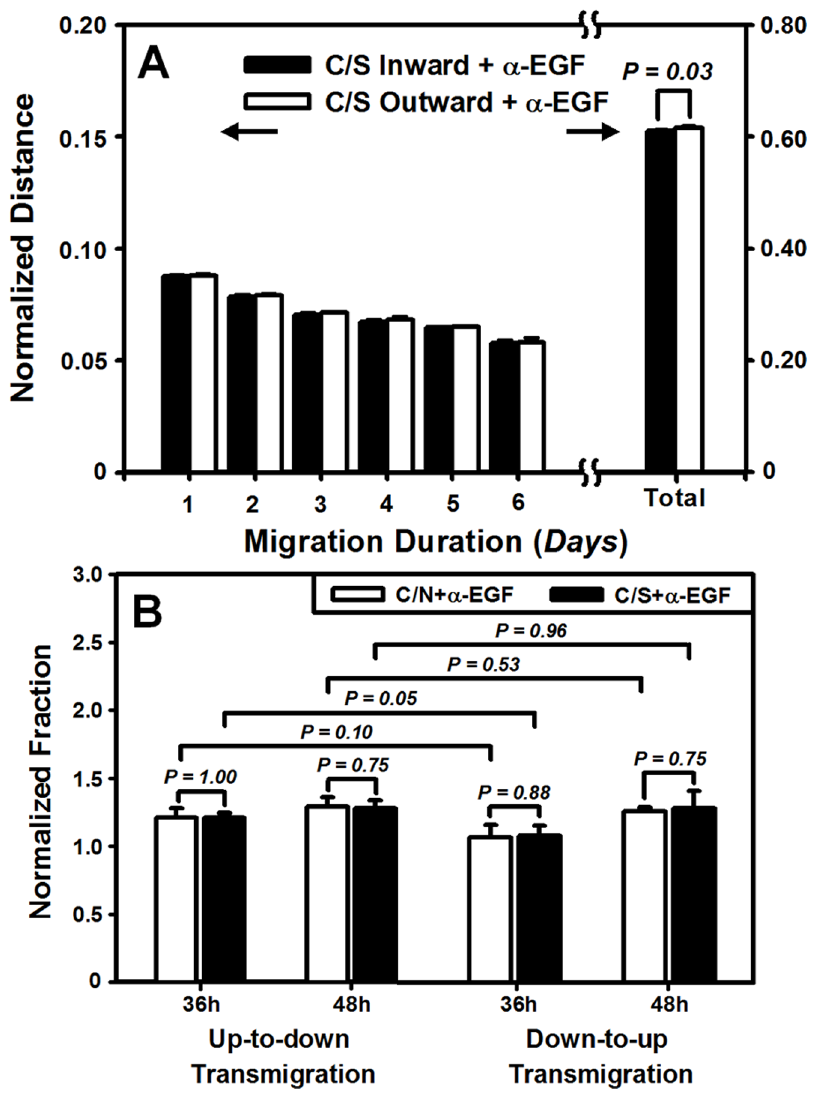
Figure 8. Inhibition of EGF in lateral ( A ) or transmembrane ( B ) migration of HaCaT cells. Data were presented as the mean 6 SD of cell migration distance normalized by initial width of HaCaT cells at t =0 day ( A ) or of fraction of transmigrated HaCaT cells at t =36, 48 h normalized to that at t =24 h in respective cases ( B ). Data at t =24 h were not presented for the sake of clarity.